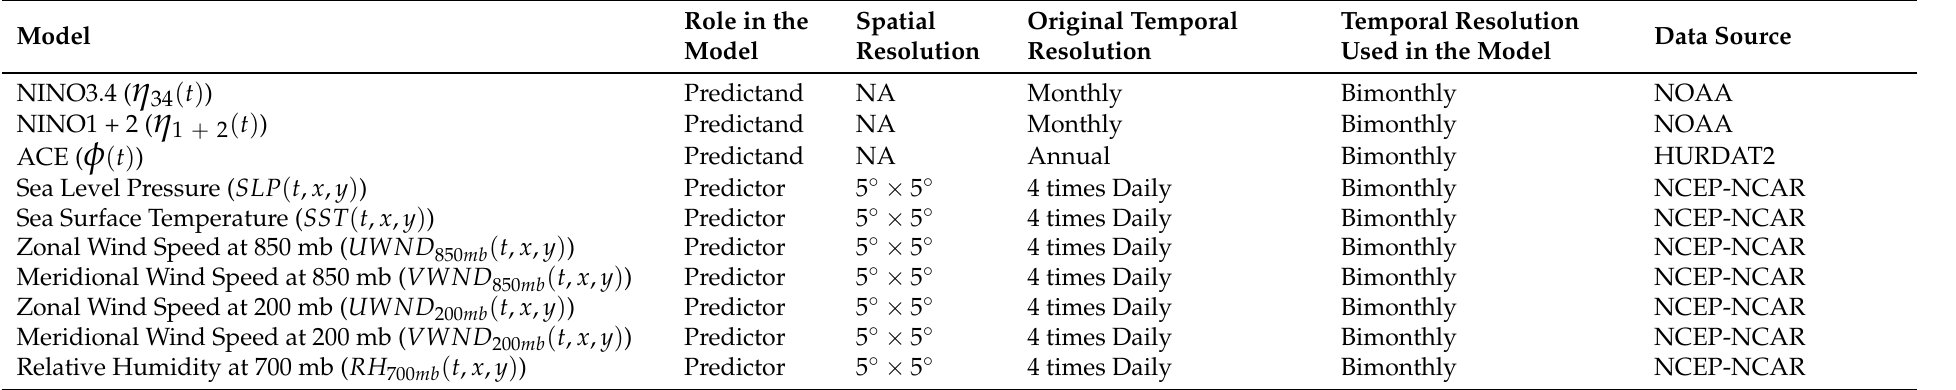
Table 1. Descriptions of data used in the prediction